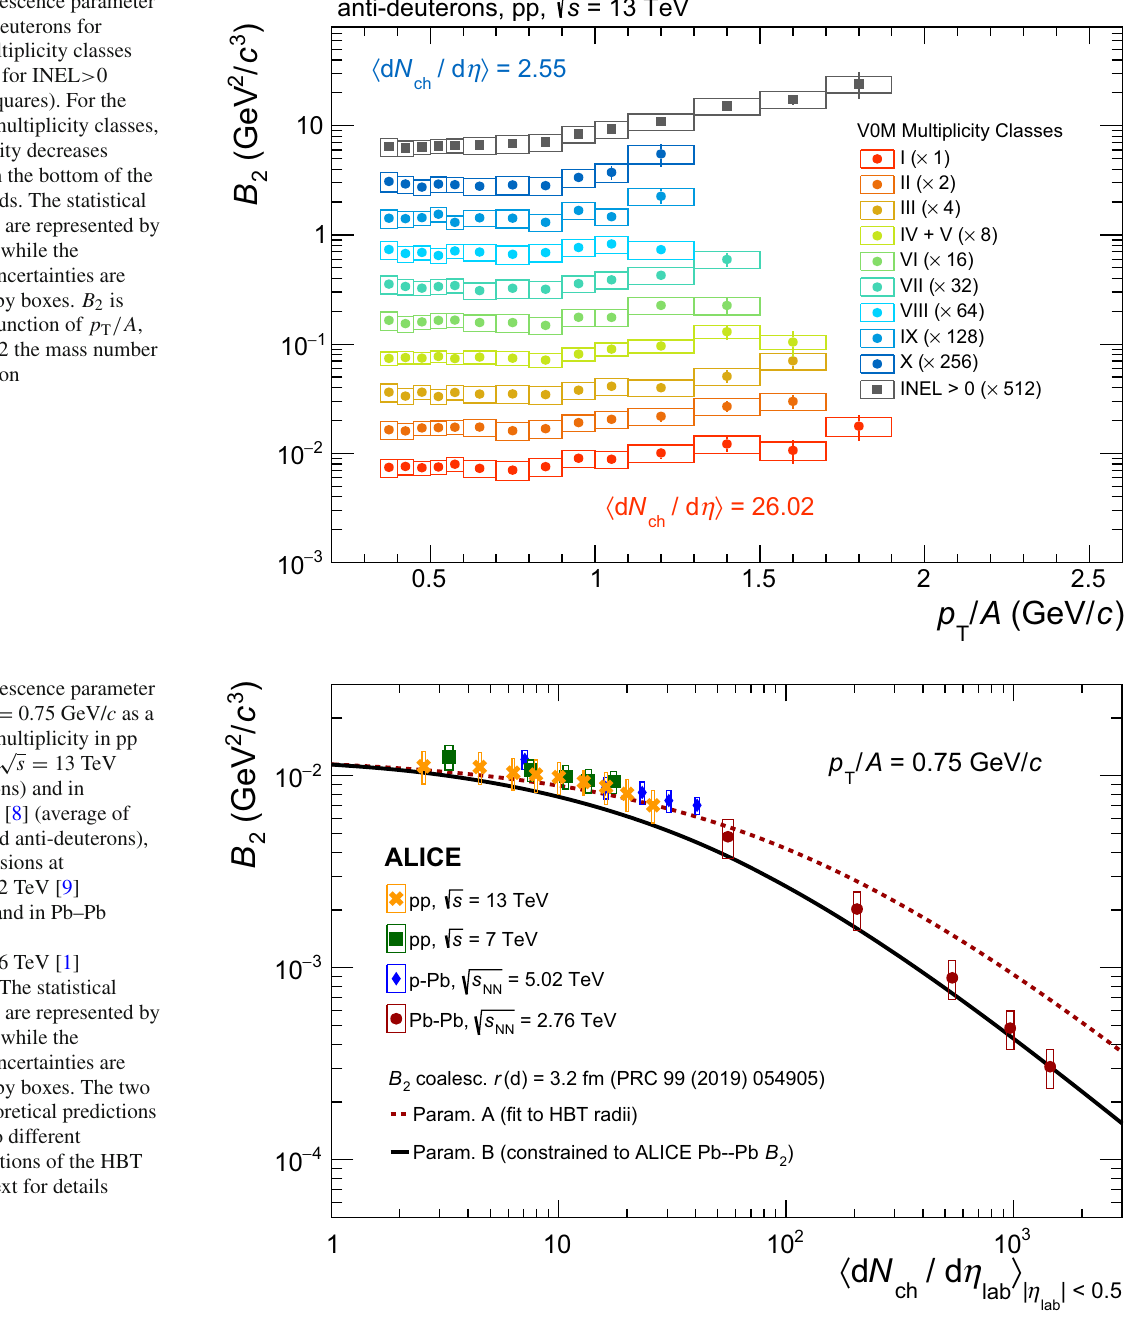
= 13 TeV s anti-deuterons, pp,